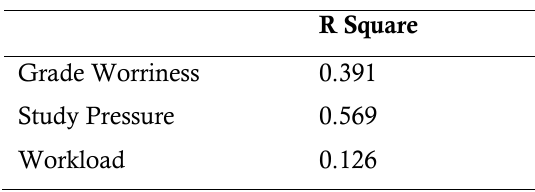
Table 5. R-Square